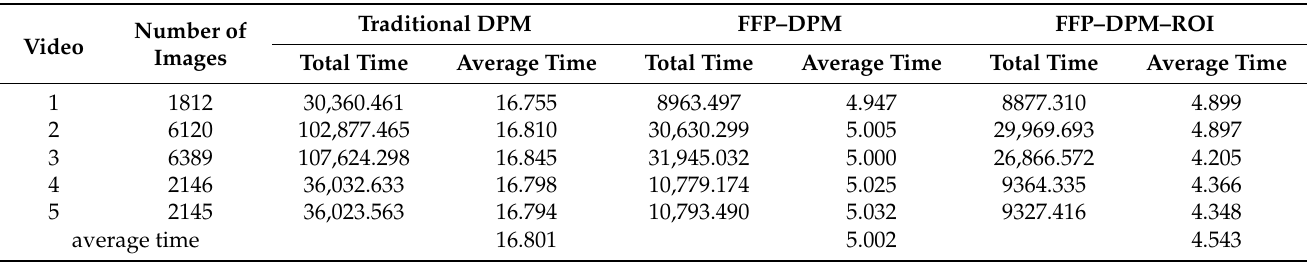
Table 1. Comparison of detection times of different algorithms for each video (s).